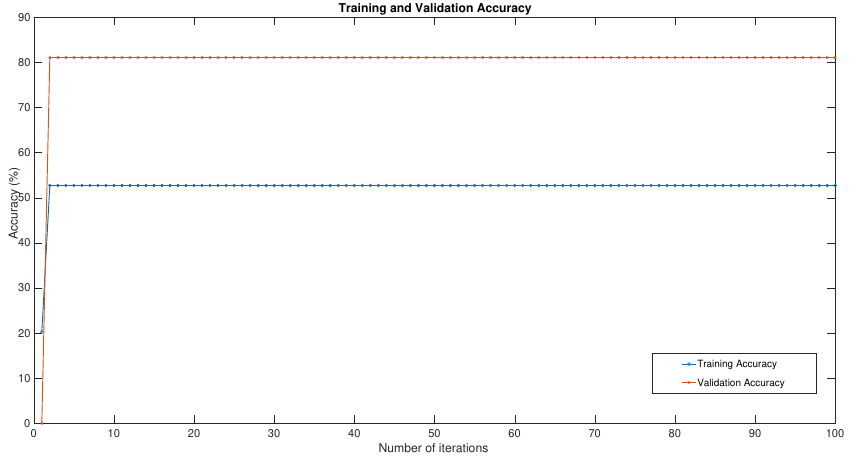
Figure 1. Accuracy plots of the iteration of Algorithm 3 from Table